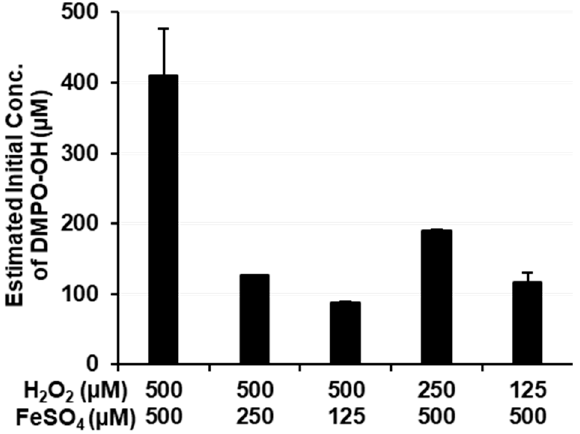
Figure 8. Estimation of the initial concentration of • OH generated by the Fenton reaction. Columns and error bars indicate the average and SD of 3 experiments.